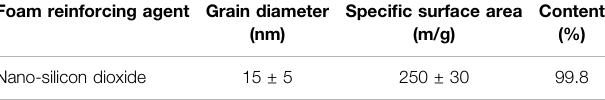
TABLE 4 | Property parameters of foam reinforcing agent.